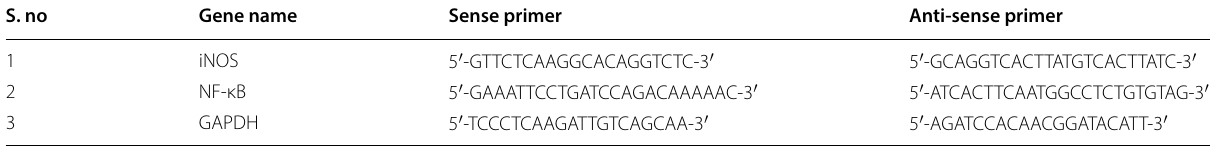
Table 1 List of primers used in real-time polymerase chain reaction